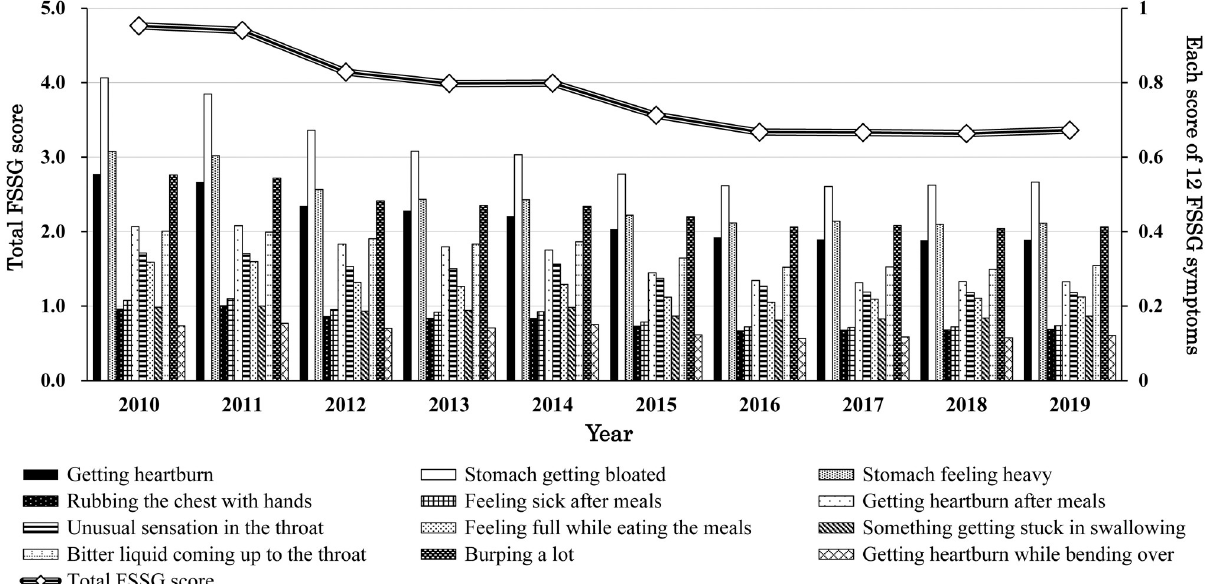
Fig 3. Changes in the total FSSG score and 12 FSSG symptoms from 2010 to 2019 in Japan. The left axis (from 0 to 5) is for the total FSSG score, and the change of total FSSG score is shown by line graph. The right axis (from 0 to 1) is for each of the 12 FSSG scores, which are shown by bar graphs from 2010 to 2019. FSSG, frequency scale for the symptoms of gastroesophageal reflux